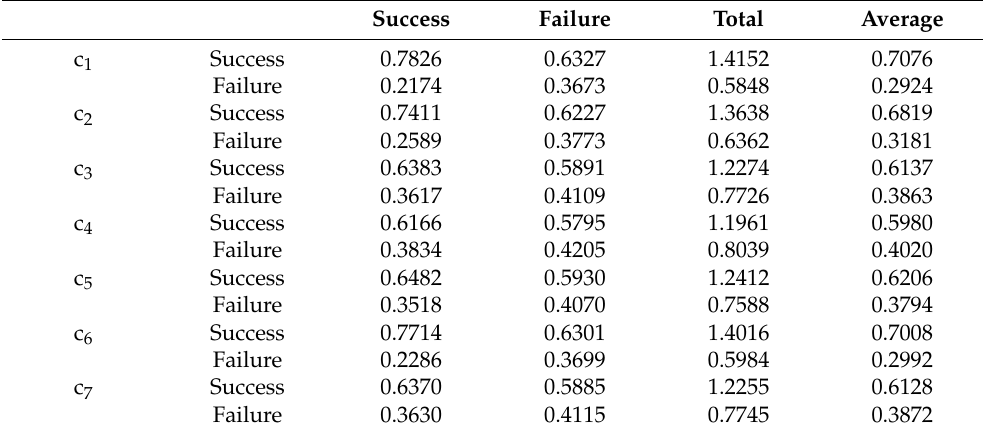
Table 14. Normalized values and priority weights of possible outcomes relying on seven criteria in Taiwan.